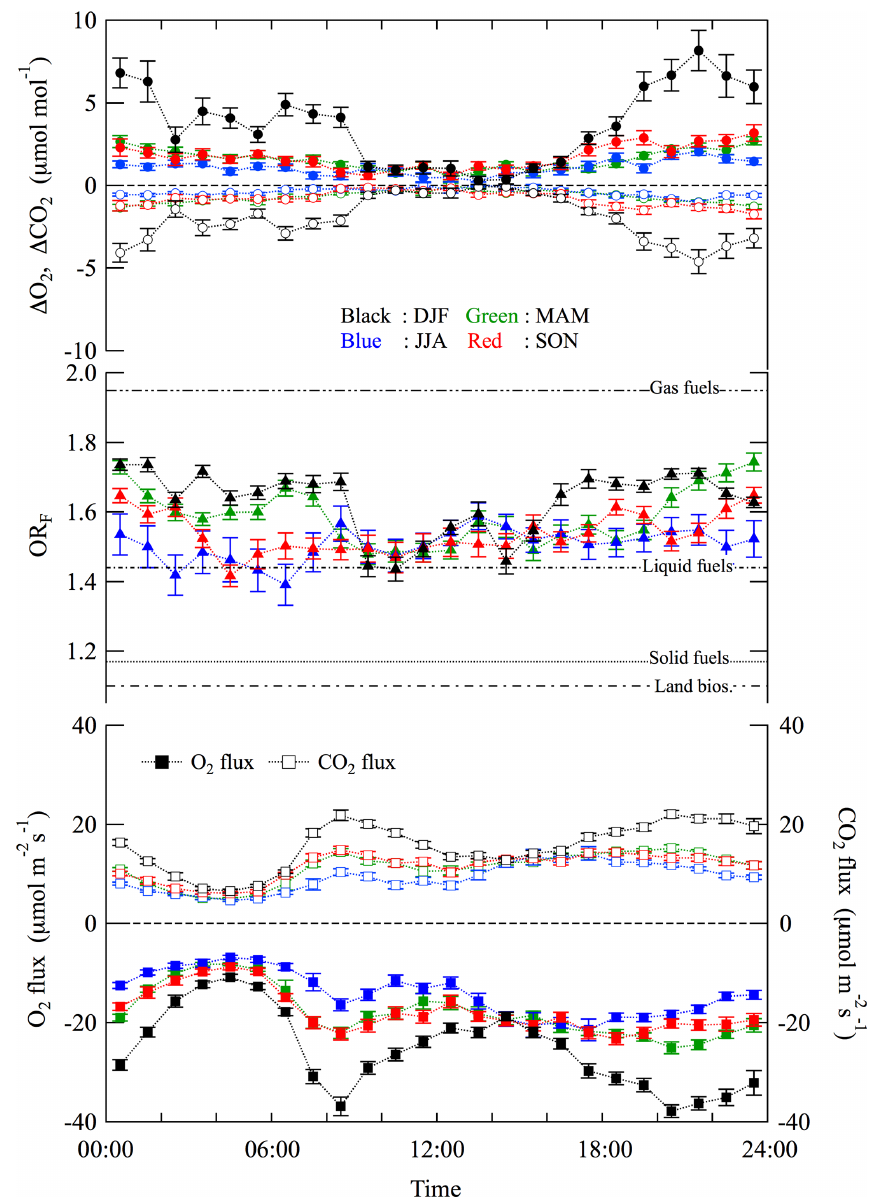
Figure 8. Plots of average diurnal cycles of (cid:49) O 2 (filled circles) and (cid:49) CO 2 (open circles) for each season: December to February (back), March to May (green), June to August (blue) and September to November (red). Average diurnal cycles of OR F , calculated by applying Deming regression fitted to the 2h period values of (cid:49) O 2 and (cid:49) CO 2 , are also plotted seasonally (see text). Average diurnal cycles of the CO 2 flux observed using the eddy correlation method, and those of the O 2 flux calculated from the CO 2 flux and OR F values, are also plotted seasonally. Error bars indicate ± 1 standard